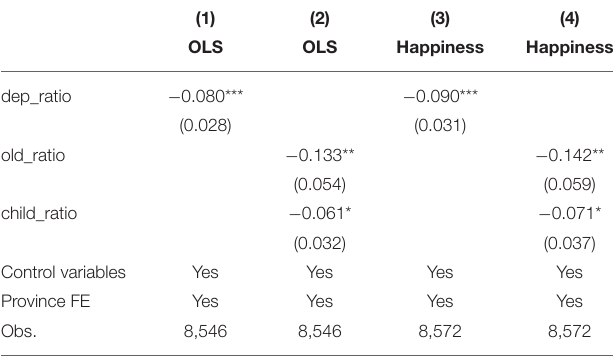
TABLE 3 | Regression results for robustness checks.